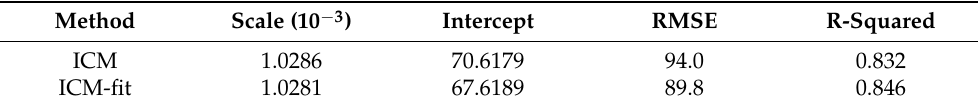
Table 5. Linear regression results after manual, visual-inspection-based outlier exclusion (values rounded to 4 decimal